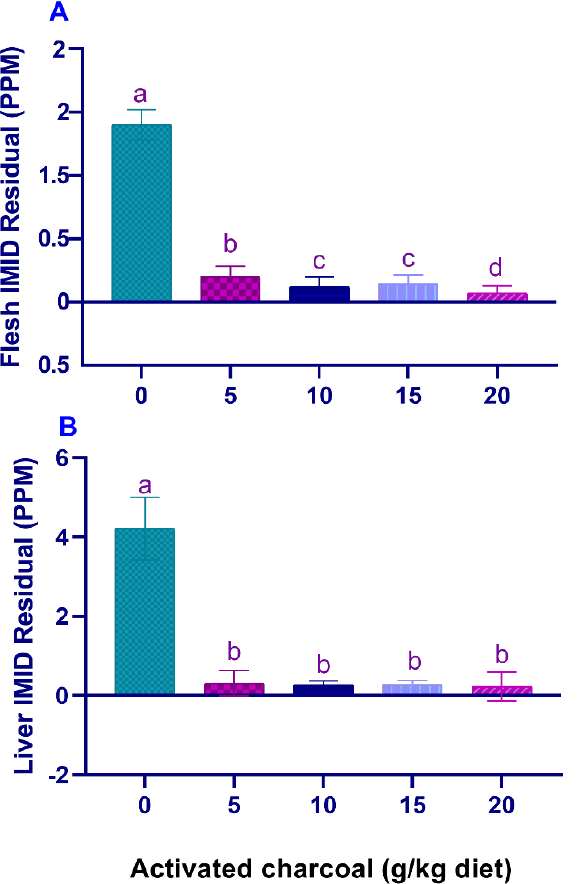
Figure 3. Residual imidacloprid (IMID) levels in the flesh ( A ) and liver ( B ) of Nile tilapia fed on diets supplemented with graded, activated charcoal (AC) levels for 2 months and then exposed to a sub-lethal IMID level for 2 weeks. (a, b, c, d) indicate significant differences between groups. Table 5. Relative percentage survival and mortality rate (%) of Nile tilapia fed diets supplemented with graded, activated charcoal (AC) levels for 8 weeks and then exposed to a sub-lethal level of imidacloprid (IMID) for 2 weeks (Experiment II).